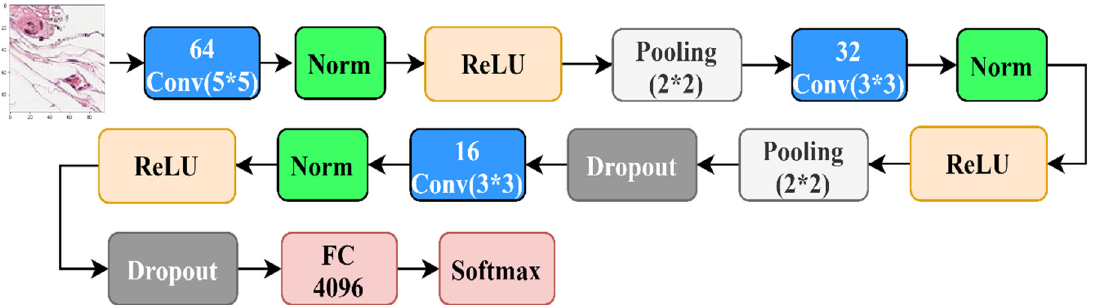
Figure 4. The architecture of Arjmand et al. [22]. Figure 7. The architecture of Arjmand et al. [22].